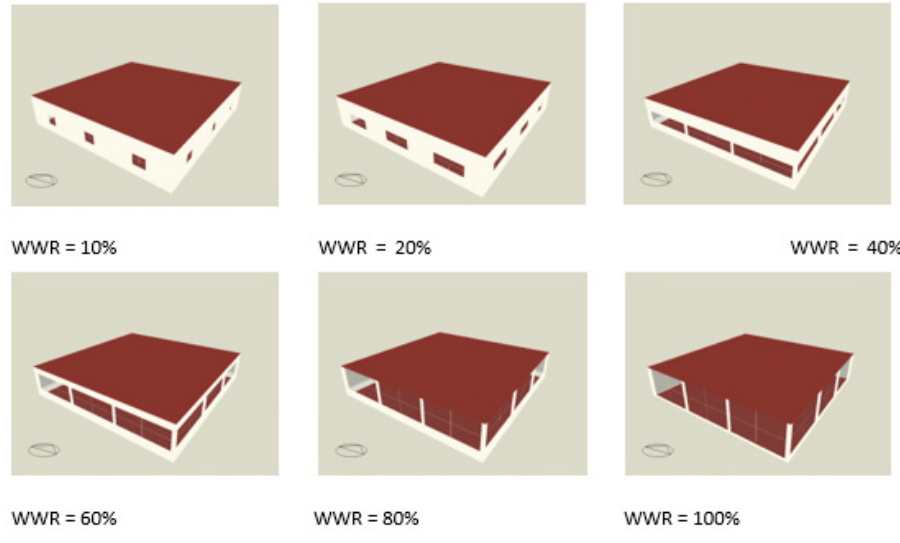
Figure 4. Window to wall ratio simulation cases. Example with first building shape.